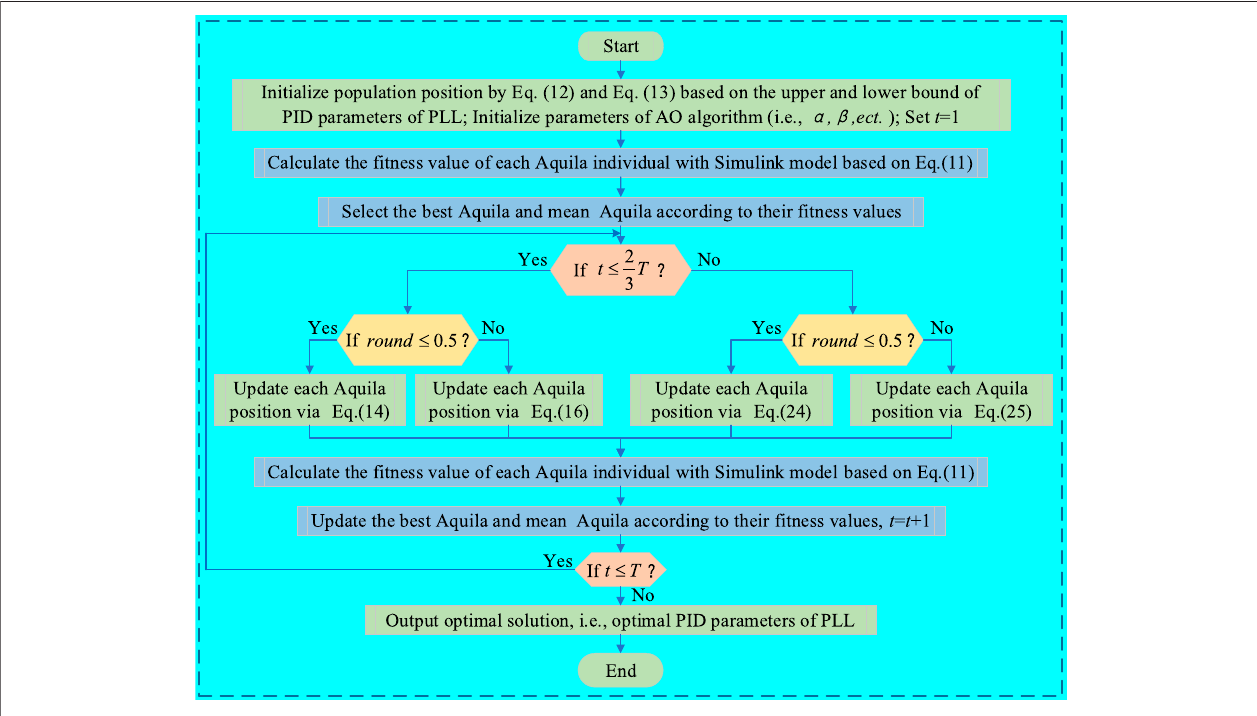
FIGURE 4 | Flow chat for PID parameter optimization of PLL with AO algorithm..